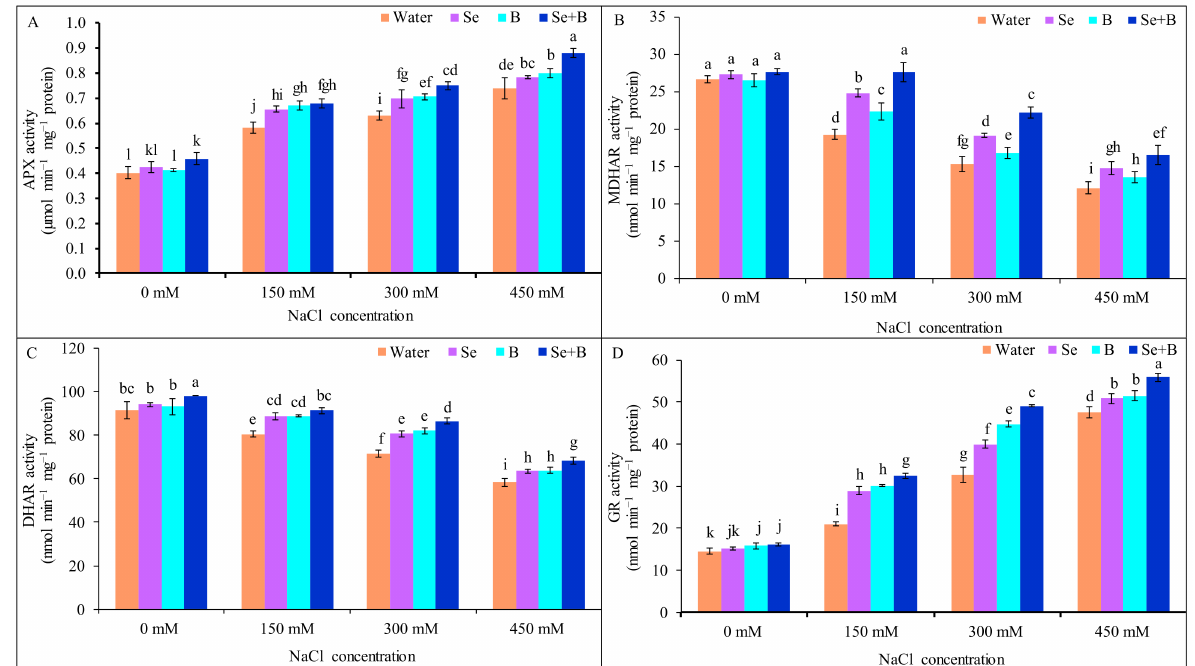
Figure 3. Effect of exogenous Se, B and Se+B on APX activity ( A ), MDHAR activity ( B ), DHAR activity ( C ) and GR activity ( D ) in soybean at 0, 150, 300 and 450 mM NaCl-induced salt stress. Here, Se, B and Se+B indicate 50 µ M Na 2 SeO 4 , 1 mM H 3 BO 3 and 50 µ M Na 2 SeO 4 + 1 mM H 3 BO 3 , respectively. Values in a column with different letters are significantly different at p ≤ 0.05 applying Fisher’s LSD